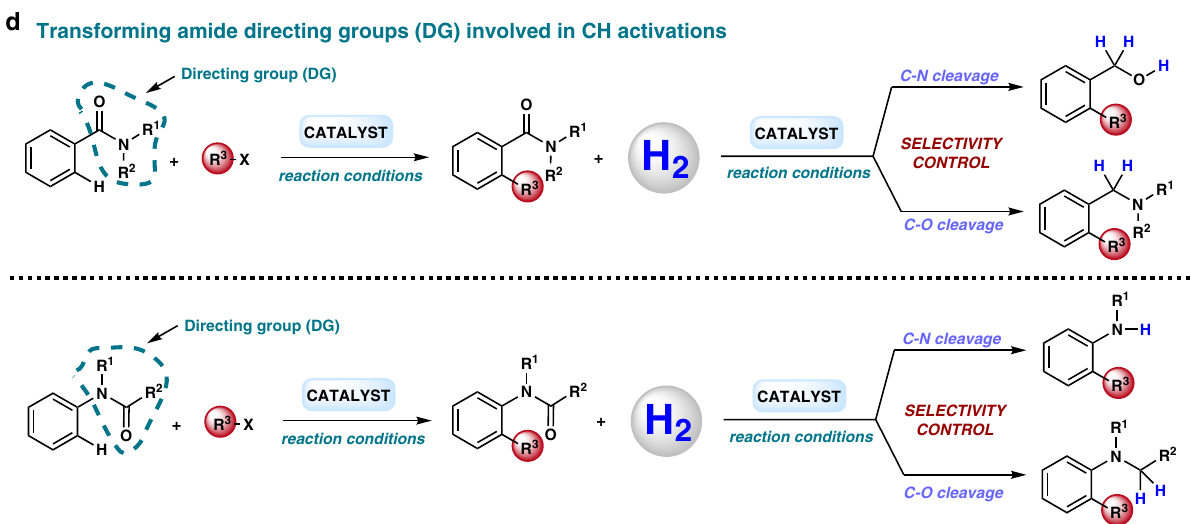
Fig. 6 Towards practical applications of amide hydrogenation. a Verapamil synthesis using a deoxygenative amide hydrogenation as key step. b Removal of chiral auxiliaries in organic synthesis via C – N hydrogenolysis. c Hydrogenative amide C = O functionalization. d Transforming amide directing groups (DG) involved in CH